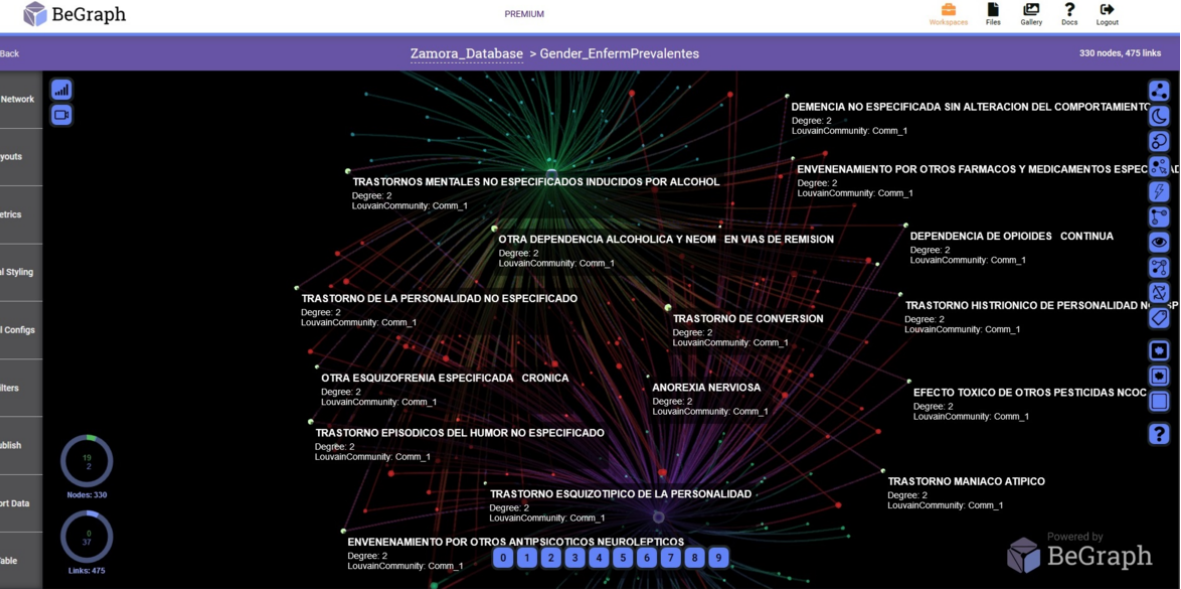
Figure 5. Network with prevalent diseases-gender in the Healthcare Complex of